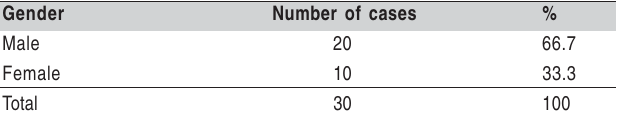
Table 1 - Distribution of cases of odontogenic cysts according to gender. São Luís, MA-2010.